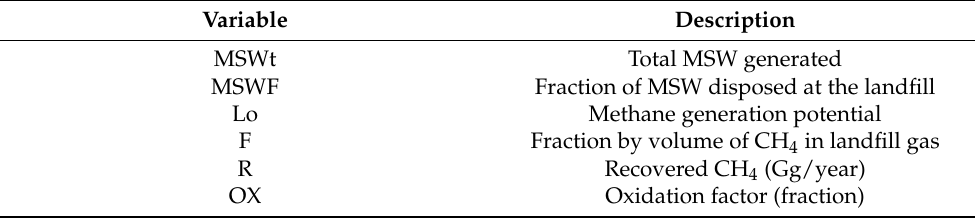
Table A3. Variables/factors needed to calculate the GHG generated linked to landfilling [83].